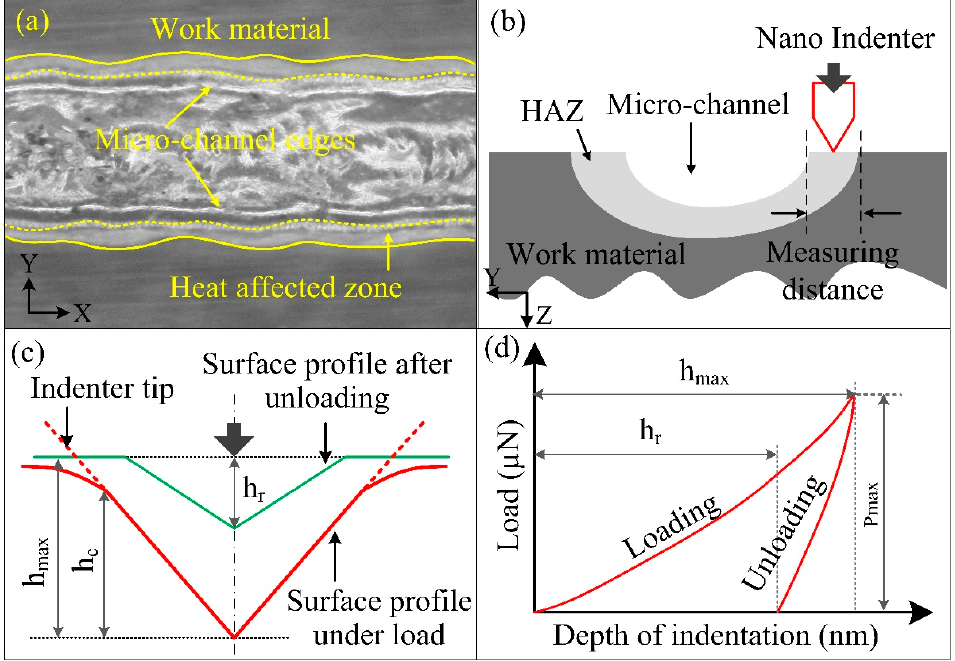
Figure 3. ( a ) Microchannel machined via ECSM process, ( b ) measurement methodology for hardness, ( c ) schematic cross-sectional representation of impression of indenter in work surface, and ( d ) load–displacement curve.